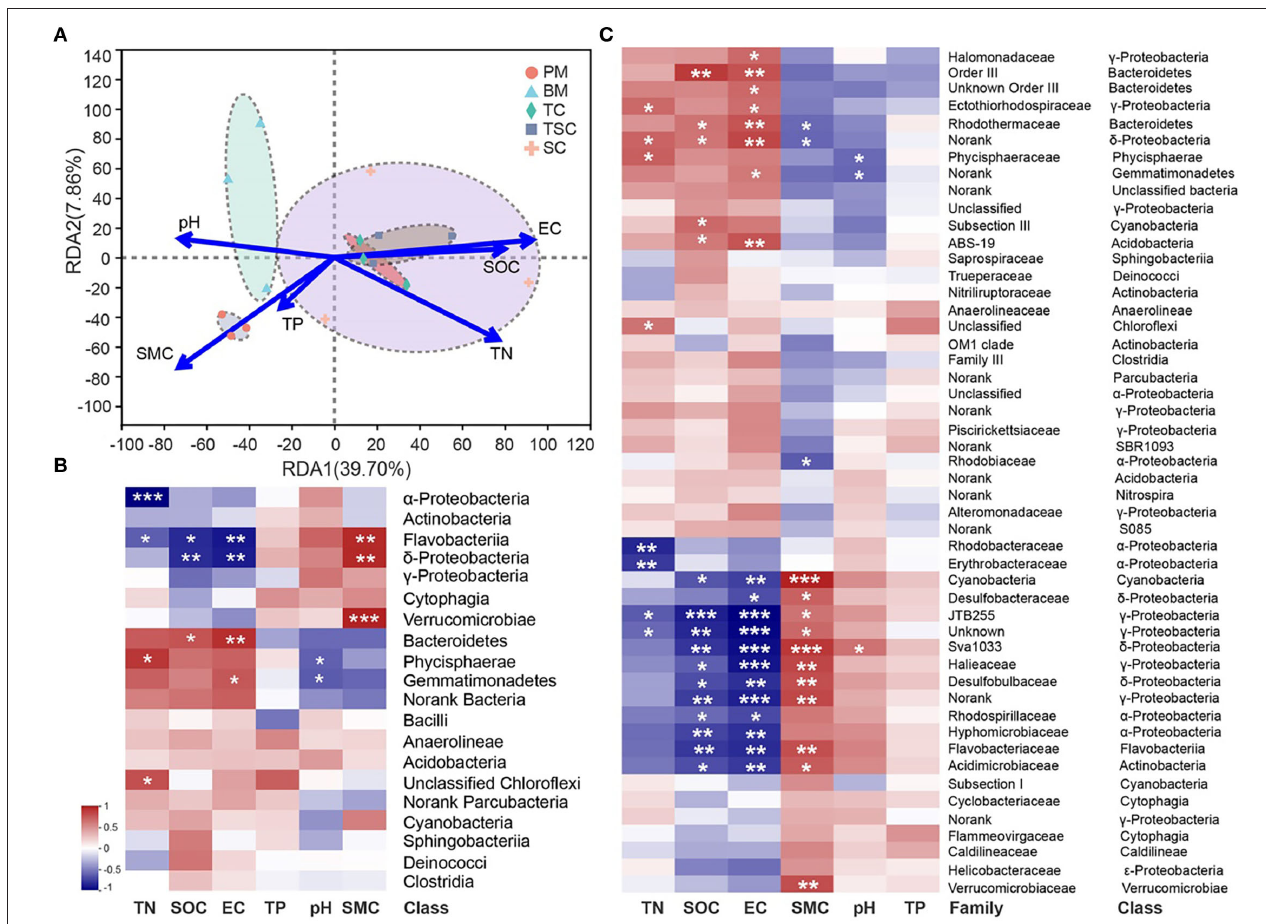
FIGURE 6 | (A) Redundancy analysis (RDA) between soil properties and bacterial community structures at class level. The correlation heatmaps of soil properties and dominant bacteria at class (B) and family (C) level. The symbol (*) indicates the significantly different bacteria. The * symbol indicates the value of p < 0.05, the ** symbol indicates the value of p < 0.01, and the *** symbol indicates the value of p <